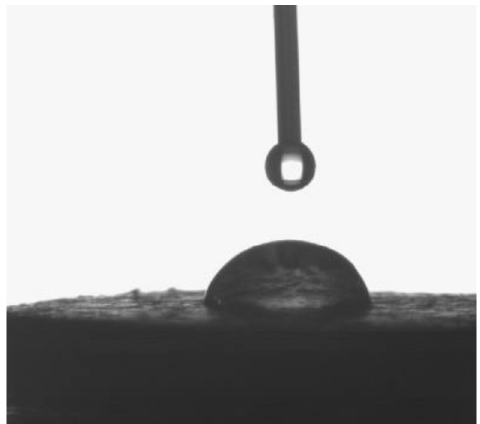
Figure 2. Example of images of water droplets recorded by Drop Shape Analyser, DSA 100, on the rock sample.